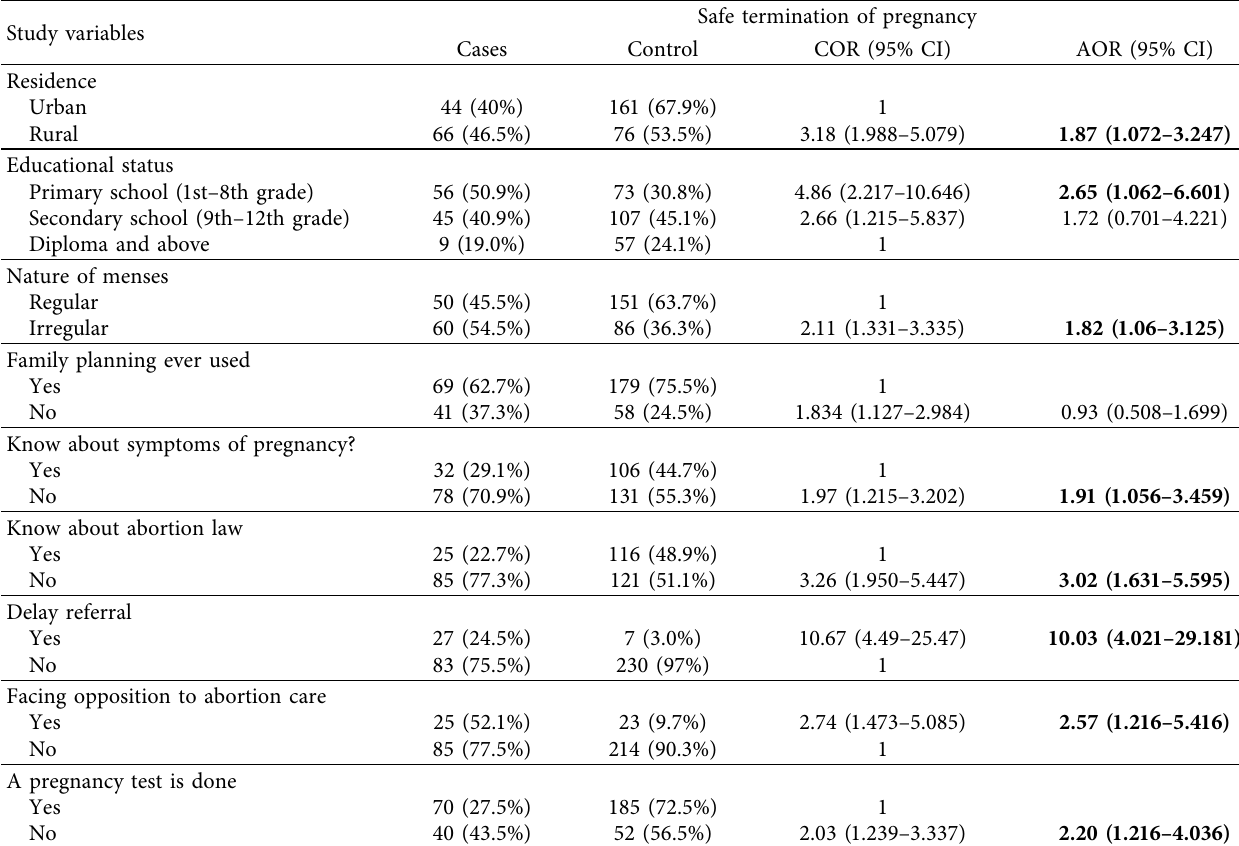
Table 3: Factors associated with delayed safe termination of pregnancy of mothers who came to Amhara region referral hospitals, northwest Ethiopia, 2020 ( N �